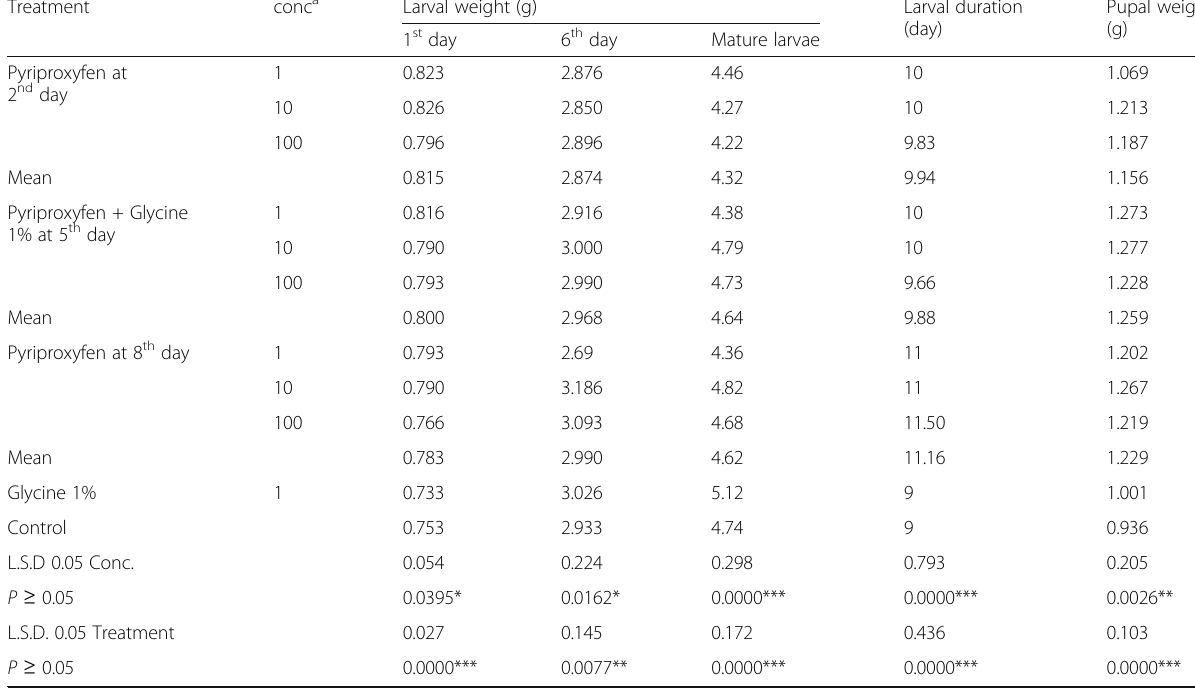
Table 1 Effect of pyriproxyfen and glycine on different biological parameters of B . mori larvae